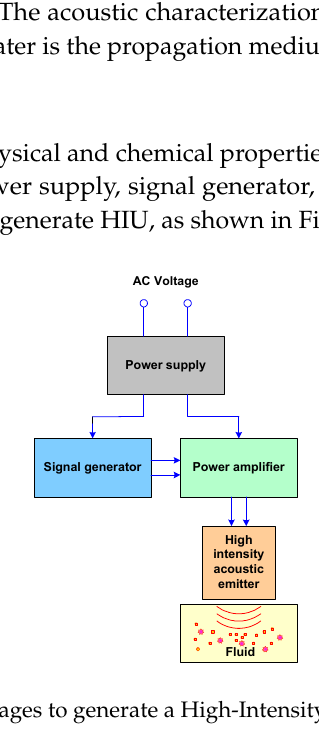
Figure 5. Determination of the acoustic properties of materials through the configurations: ( a ) transmission and ( b ) pulse echo.